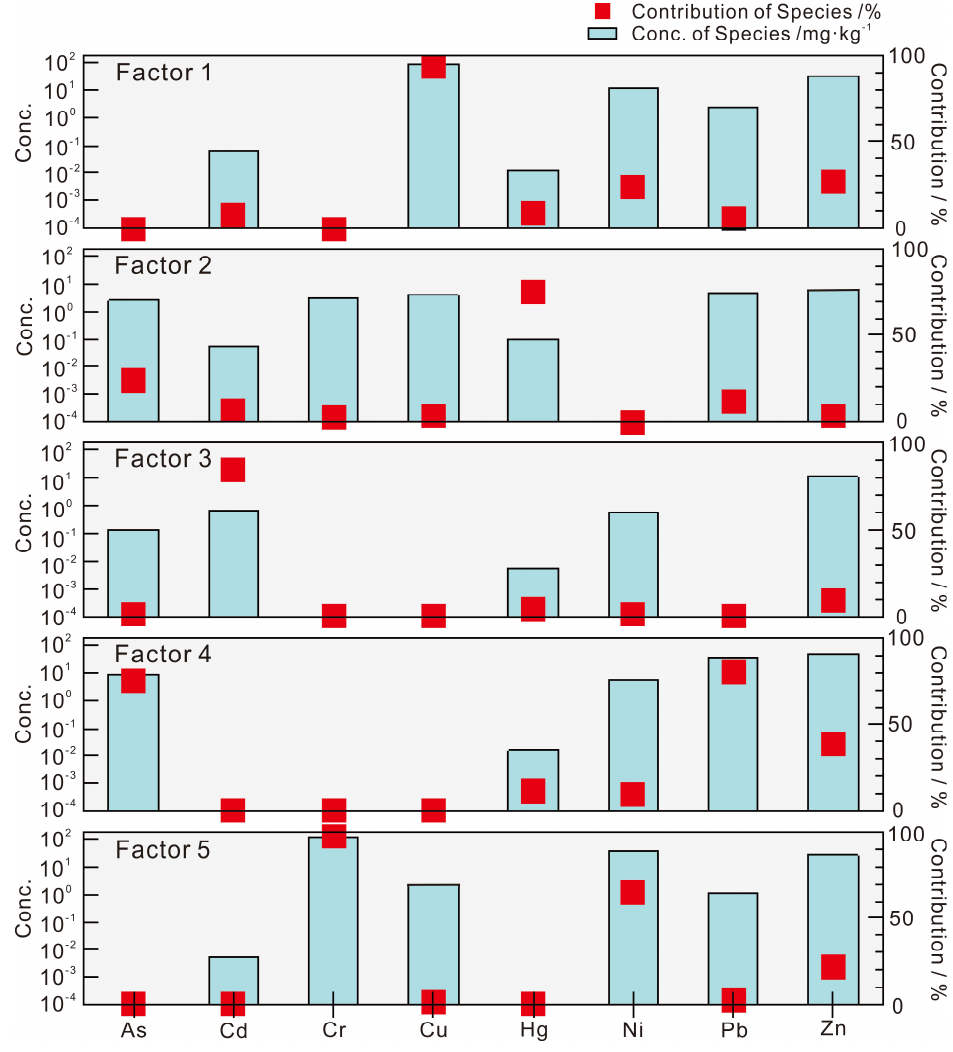
Figure 7. Factor profiles and source contributions of heavy metals from the PMF